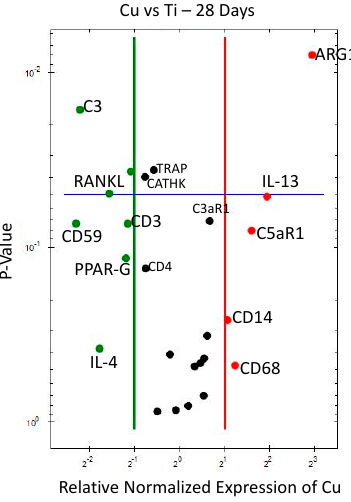
Figure 4. Volcano plot for gene expression analysis of Cu compared to Ti (28 days). Downregulation (vertical green line) and upregulation (vertical red line) set at × 2 regulation. Statistical significance (set at p < 0.05) when marker above horizontal blue